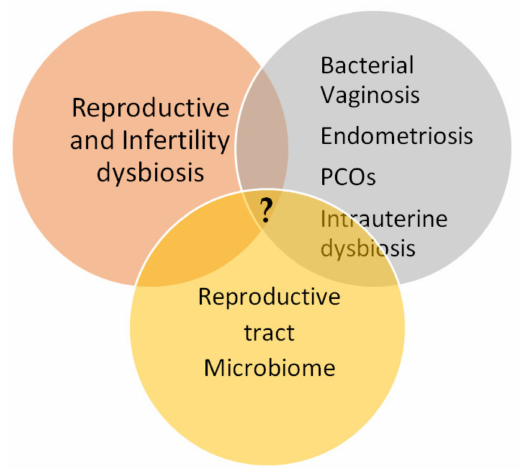
Figure 1. Intersection gap knowledge of reproductive system disorders, unexplained infertility, microbiome dysbiosis, and recurrent reproductive